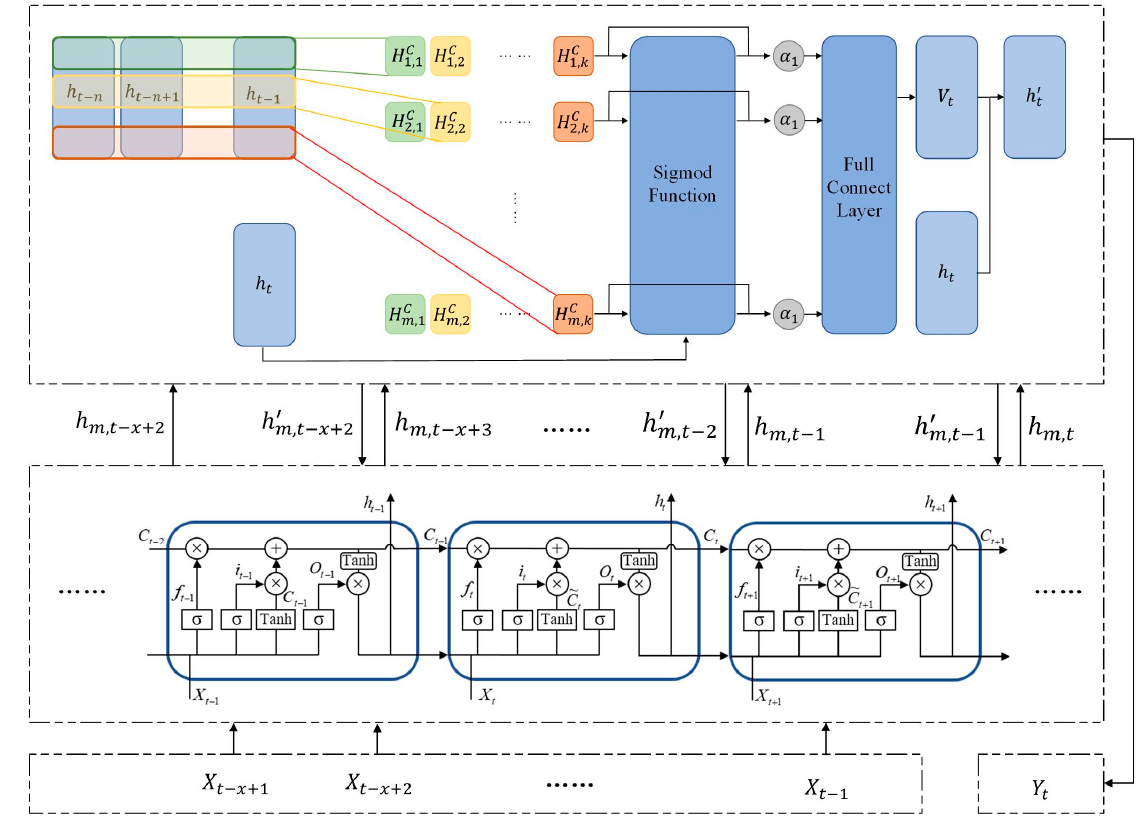
Figure 6. Temporal pattern attention (TPA)-LSTM